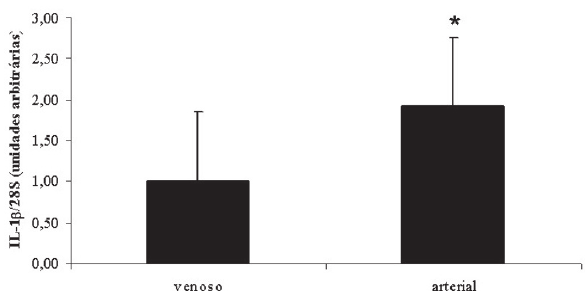
Fig. 2 - Expressão da Interleucina-1ß em veia safena humana cultivada em regime venoso e arterial por 24 horas. A quantificação foi realizada por RT-PCR em tempo real em amostras de 16 indivíduos. (* indica p<0,05 em relação à condição venosa) Análise de imuno-histoquímica mostrou que